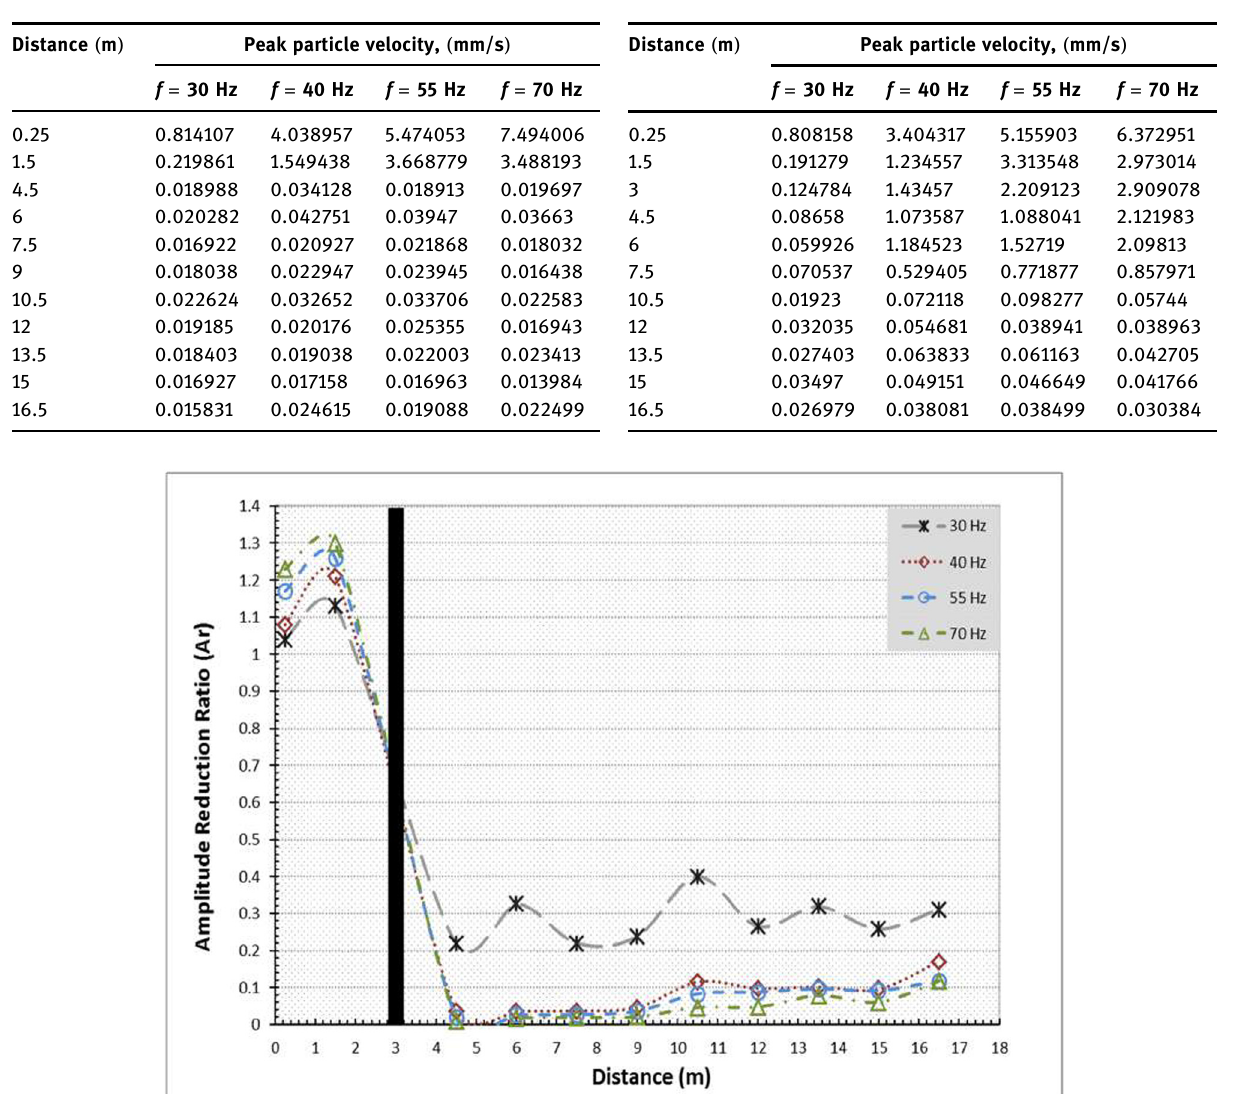
Table 6: The measured peak particle velocities at di ff erent locations for various frequencies ( passive open trench barrier )